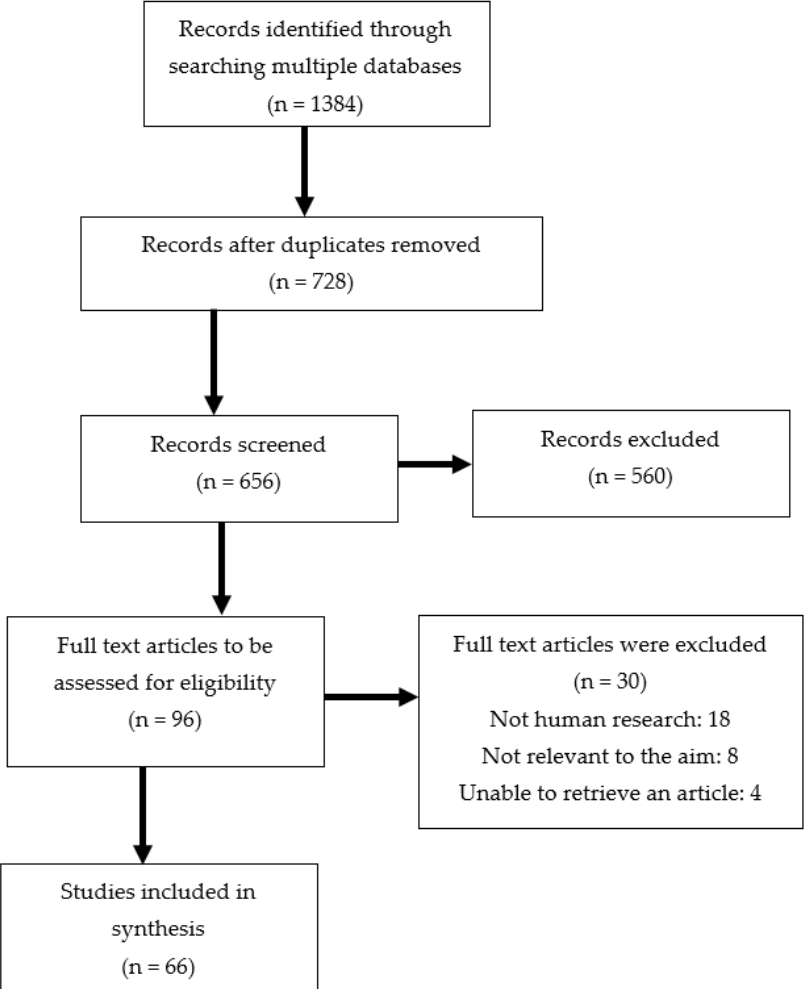
Figure 1. Flow chart of the proceedings in the selection of